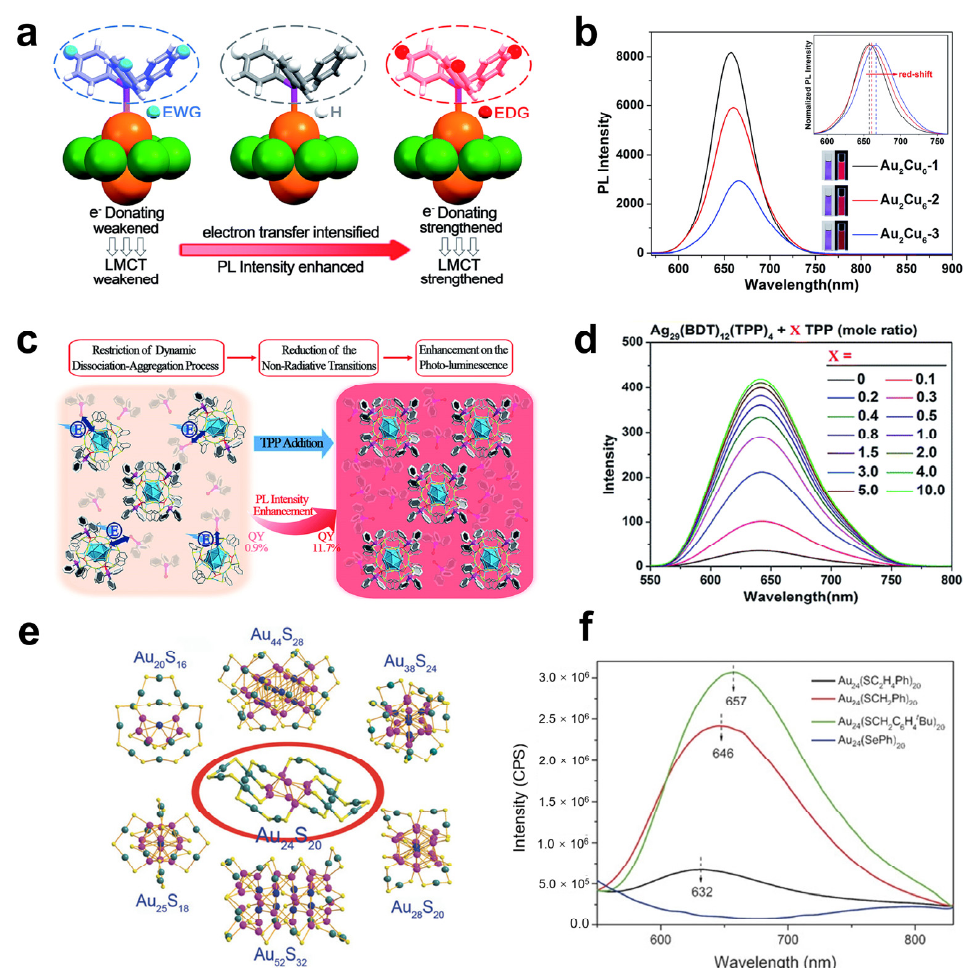
Figure 4. Ligand shell-related photoemission of MNCs. ( a ) The illustrations of decreased LMCT and fluorescence induced by the electron-deficient group of EWG as well as enhanced LMCT and fluorescence induced by the electron-withdrawing group of EDG. ( b ) The spectra on the PL of the two ligand-treated and pristine Au 2 Cu 6 NCs. Copyright (2017) Royal Society of Chemistry. ( c ) Schematic illustration of the limited surface ligand dissociation process of Ag 29 (BDT) 12 (TPP) 4 NCs after the addition of triphenylphosphine. ( d ) PL intensity variation in Ag 29 (BDT) 12 (TPP) 4 NCs after a different amount of triphenylphosphine was added. Copyright (2018) Royal Society of Chemistry. ( e ) Structural frameworks of various Au nanoclusters. ( f ) Fluorescence spectra of four different ligand-protected Au24(SR)20 NCs. Copyright (2016) Wiley-VCH.